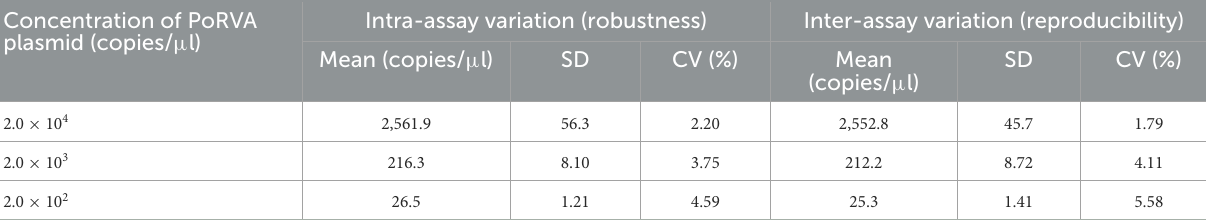
TABLE 3 Robustness and reproducibility analysis of droplet digital PCR (ddPCR). Concentration of PoRVA plasmid (copies/ µ